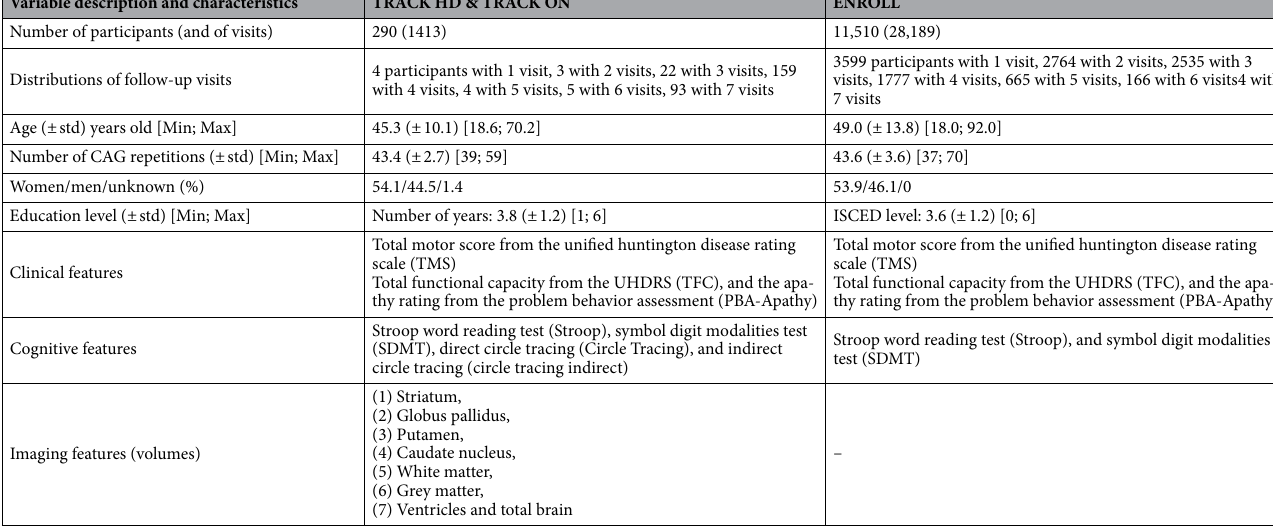
Table 1. Demographic description of participants from the two TRACK studies (TRACK-HD and TRACK ON) and the ENROLL-HD